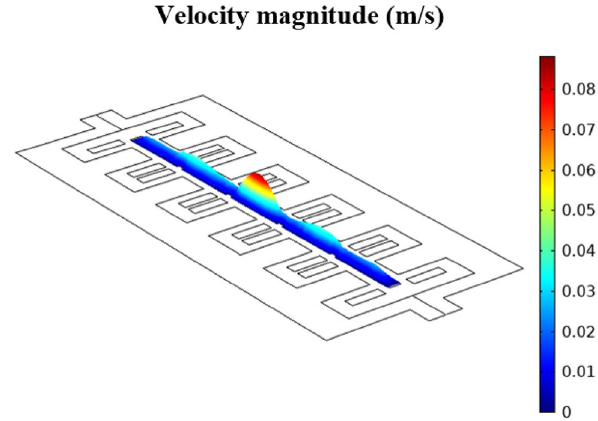
Fig. 12 The 3D contour of the velocity